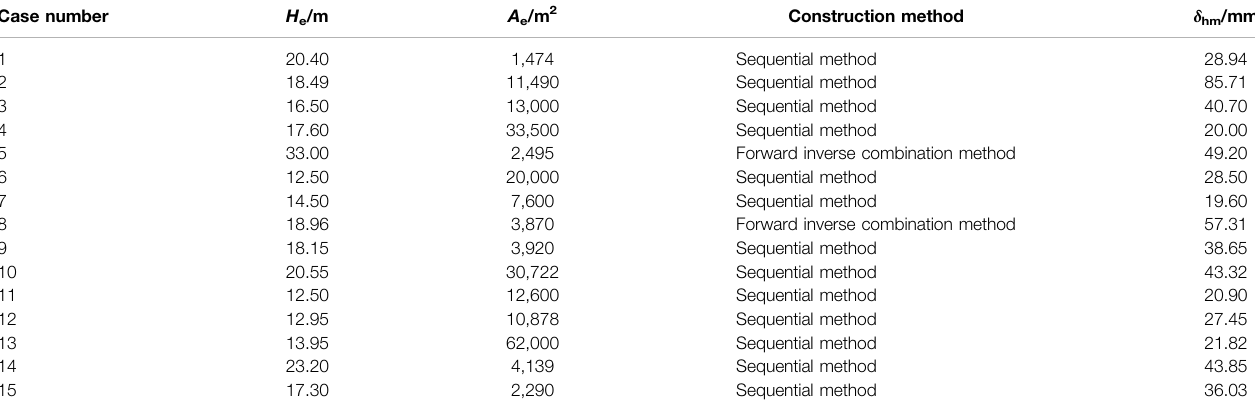
TABLE 3 | Summary of basement excavations in Suzhou soft clay.